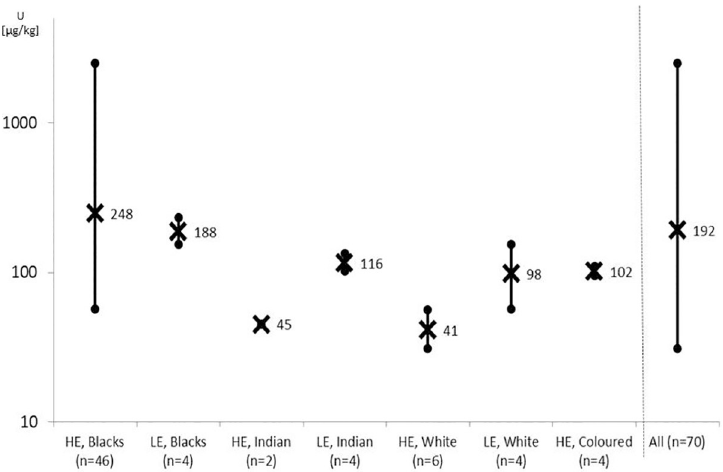
Fig 2. Uranium (U) concentrations in μ g/kg measured in composite hair samples from assumed high-exposure (HE) and low-exposure (LE) wards by race (wards with mostly Black, Coloured, Indian, or White populations), with sex-weighted arithmetic mean (X) and range (maximum and minimum) in n measurements ( n = number of composite samples measured). The “All” group comprises all 70 measured composite samples from HE and LE wards combined (all shown in Table